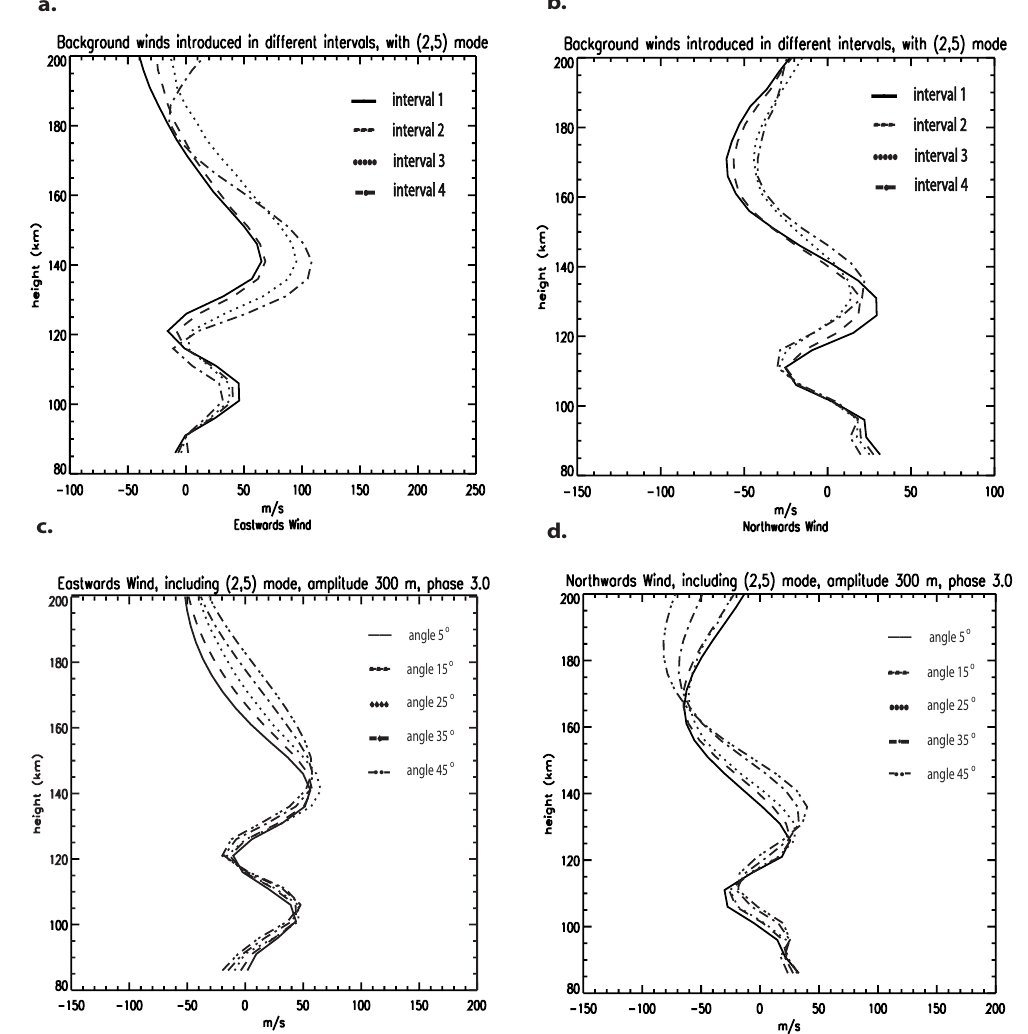
Fig. 4. (a) , (b) Effects of introducing background winds including the (2,5) mode at the beginning of different intervals, and (c) , (d) effects of changing the angle between the aurora and the background wind